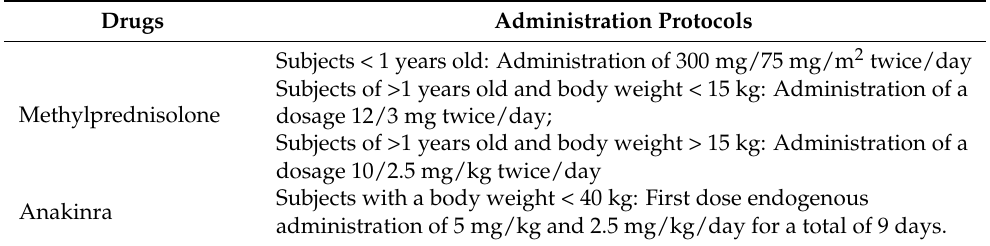
Table 7. COVID-19 immunomodulant dosage summary. Drugs Administration Protocols